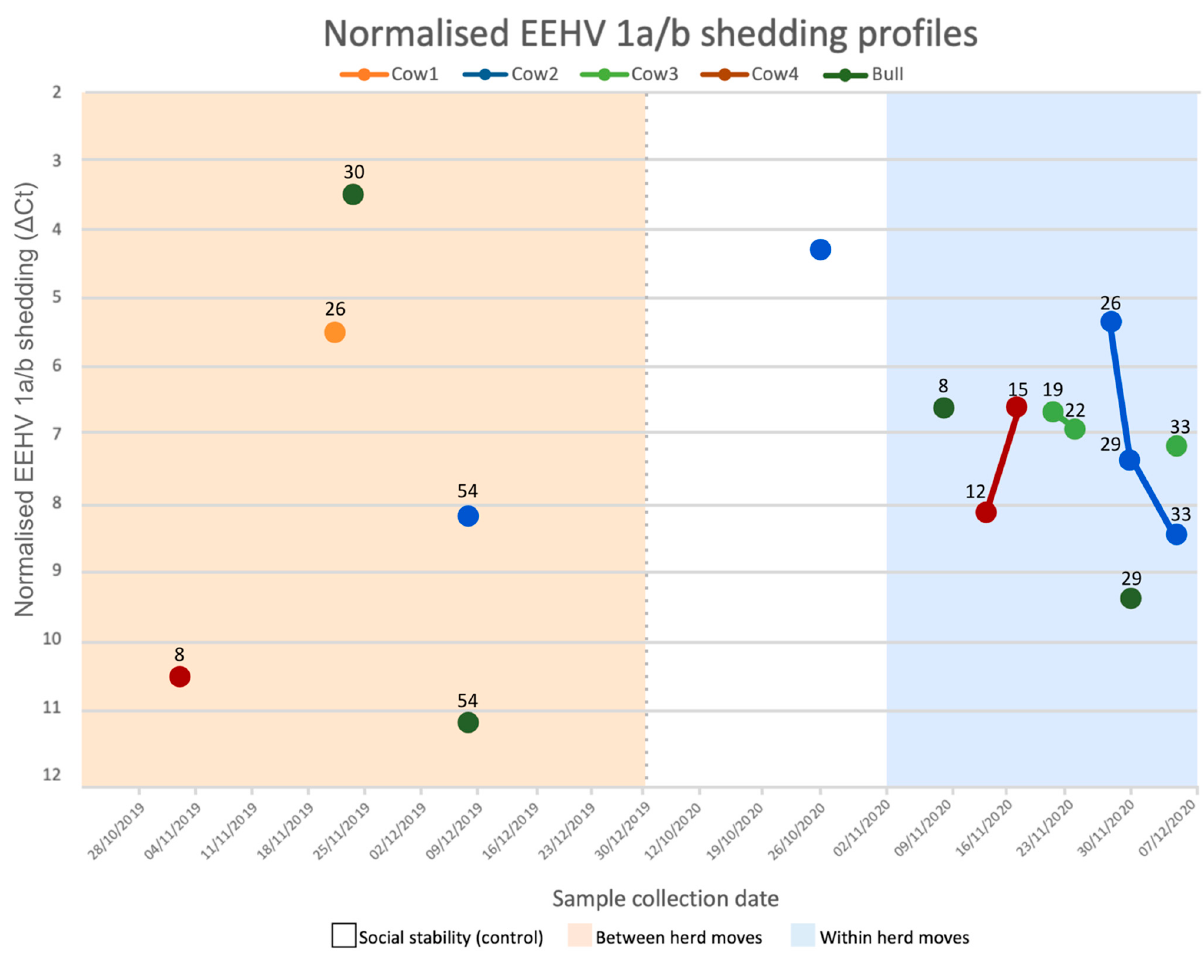
Figure 5. EEHV 1a/b normalised shedding profiles for each sampled Asian elephant. Values above each data point indicate the number of days post the first management event (i.e., 25 November 2019 for between herd moves and 1 November 2020 for within herd moves). Samples that are joined by a line were collected over sequential sampling dates. The y-axis is flipped to appropriately represent the inverse relationship between Δ Ct (normalised shedding) and relative viral DNA loads, as low Δ Cts represent high viral DNA. Sample collection dates are listed by week, beginning on Mondays. The dotted grey line indicates a 10-month separation between periods. Tactile touch behind a barrier was allowed following 18 November 2019. This shedding profile describes positive EEHV samples only. Elephants did not present detectable EEHV 1a/b nor 4a/b DNA at all other sampling points.